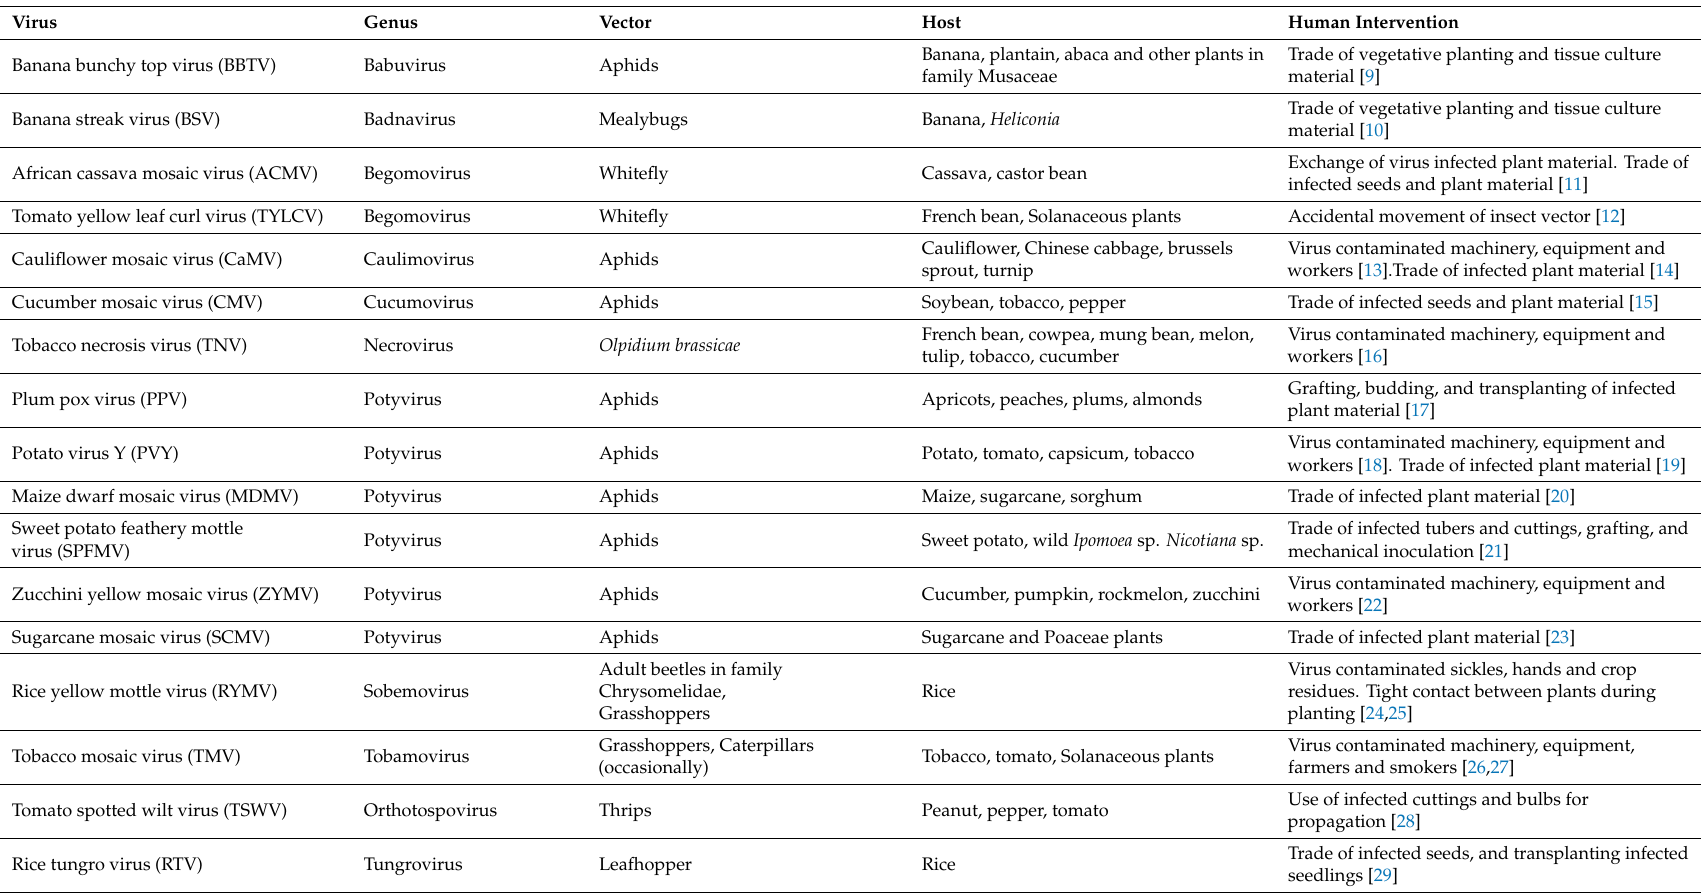
Table 1. Human intervention in the spread of plant